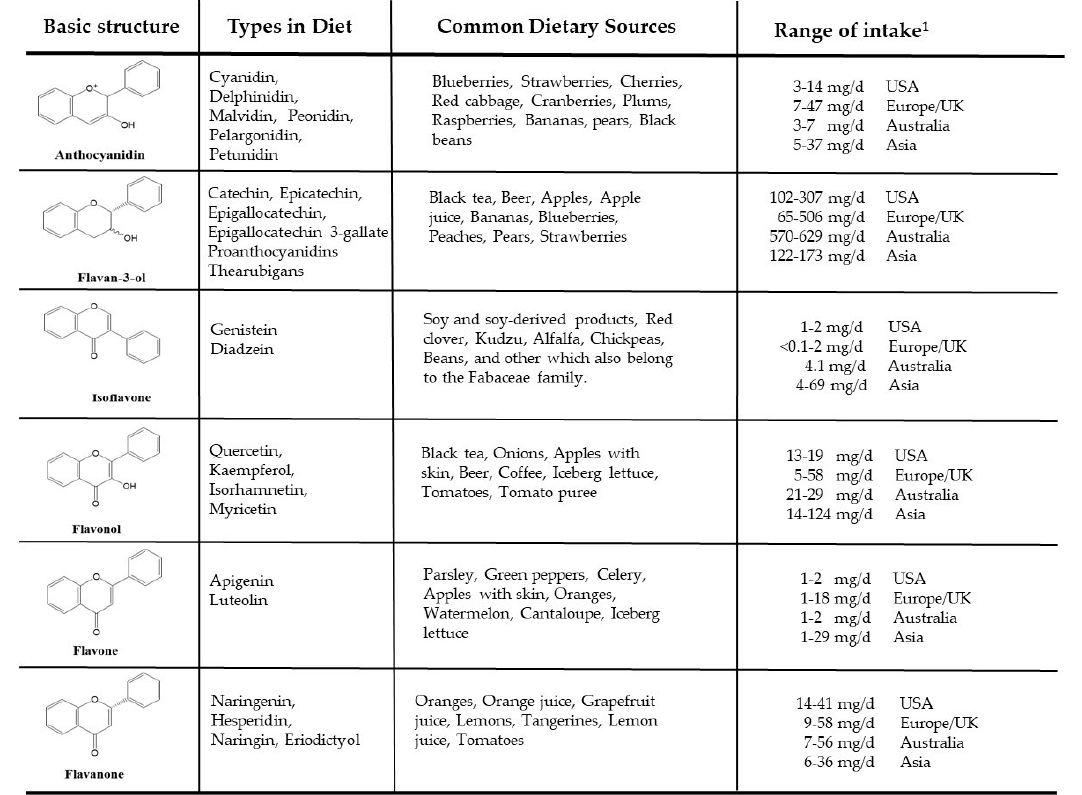
Figure 2. Flavonoid compounds, dietary sources and daily intake range. 1 Aglycone values